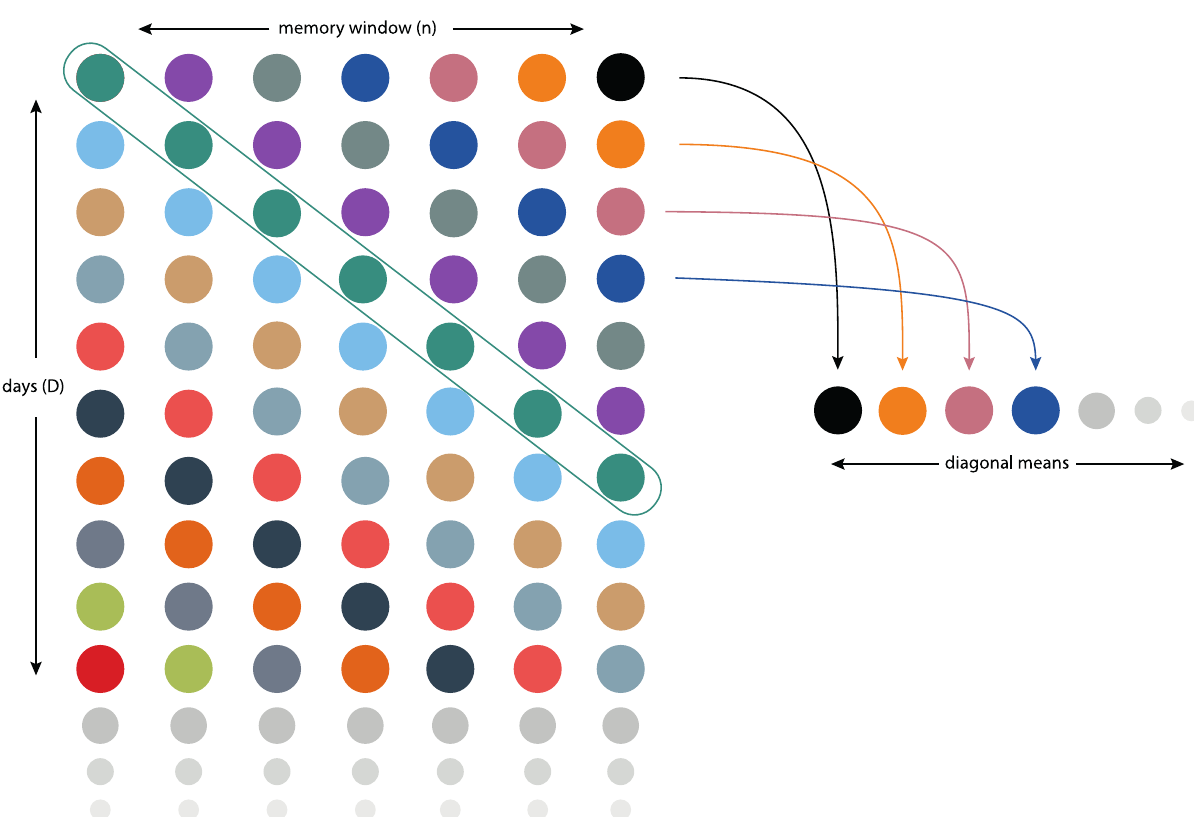
Fig 2. Diagonal mean—Feature importance. Mean of diagonal means to compute a single importance value for a single feature in the context of an LSTM model.